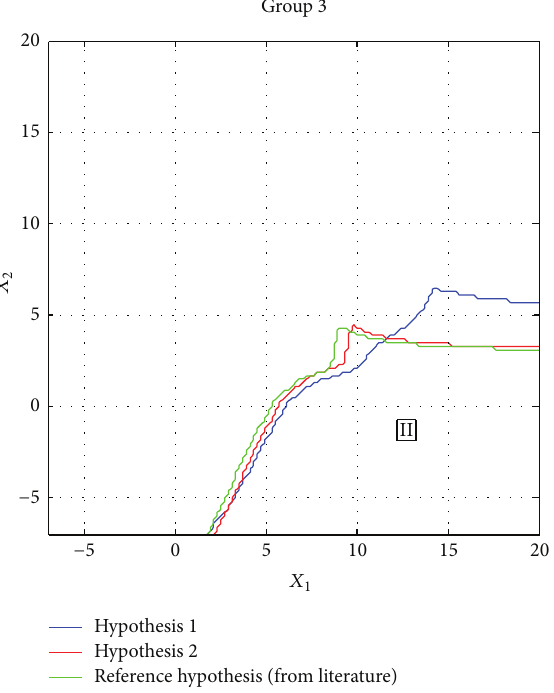
Figure 16: Setup policy (product 1 to product 2).